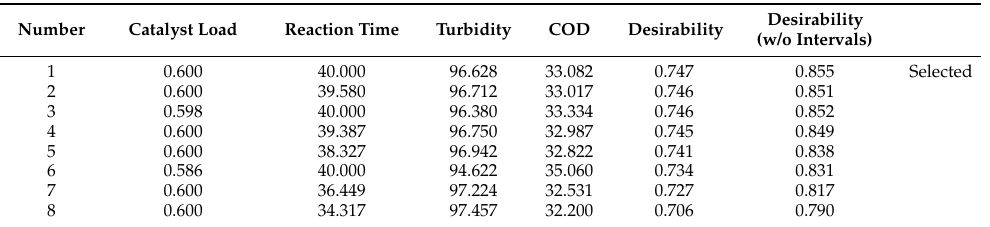
Table 9. Solutions generated.